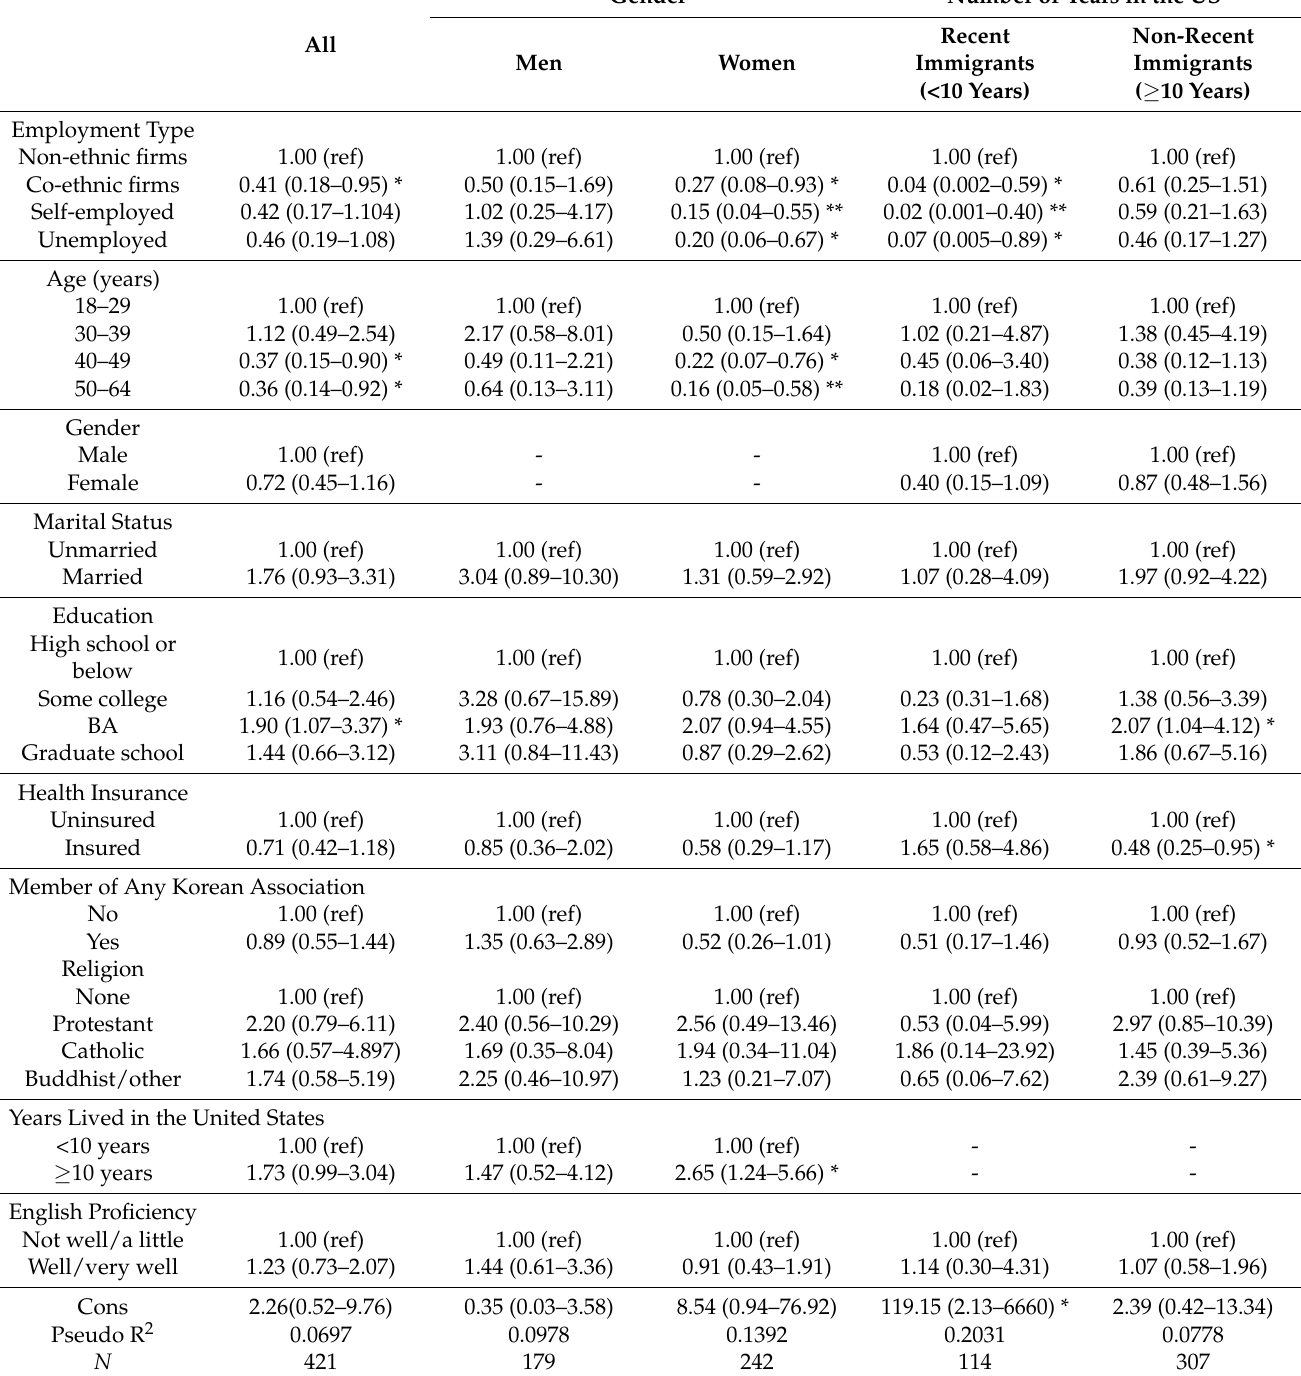
Table 3. Logistic Regression Predicting Self-Rated Health by Gender and Number of Years in the US (OR, 95% CI). Gender Number of Years in the US All Men Women